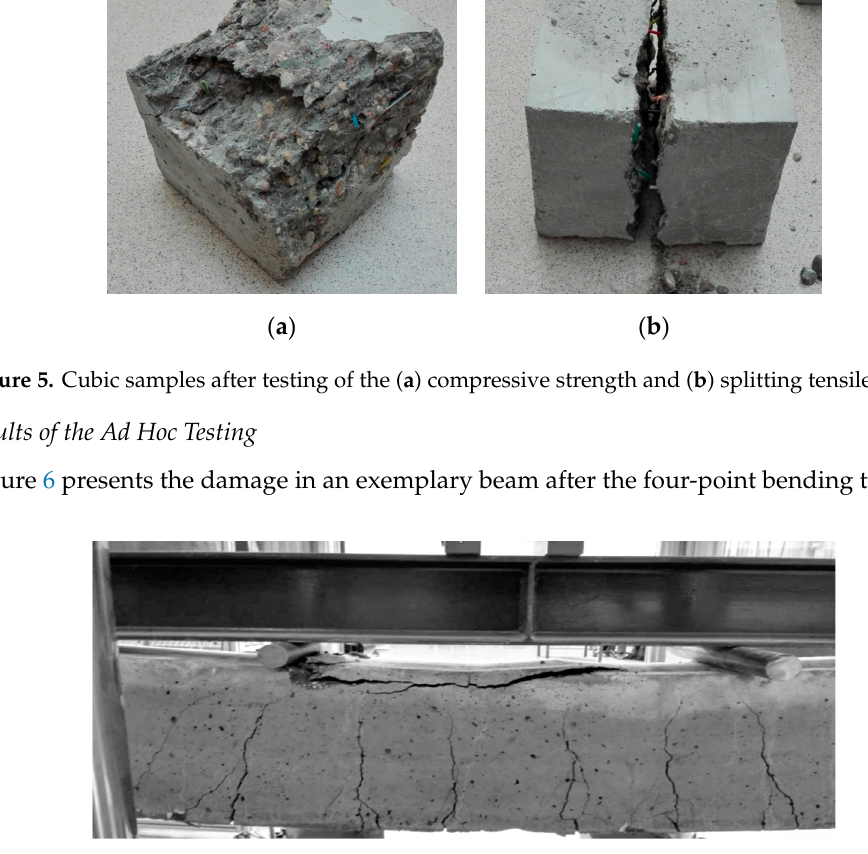
Figure 6. Image of reference beam damage in C1 concrete.